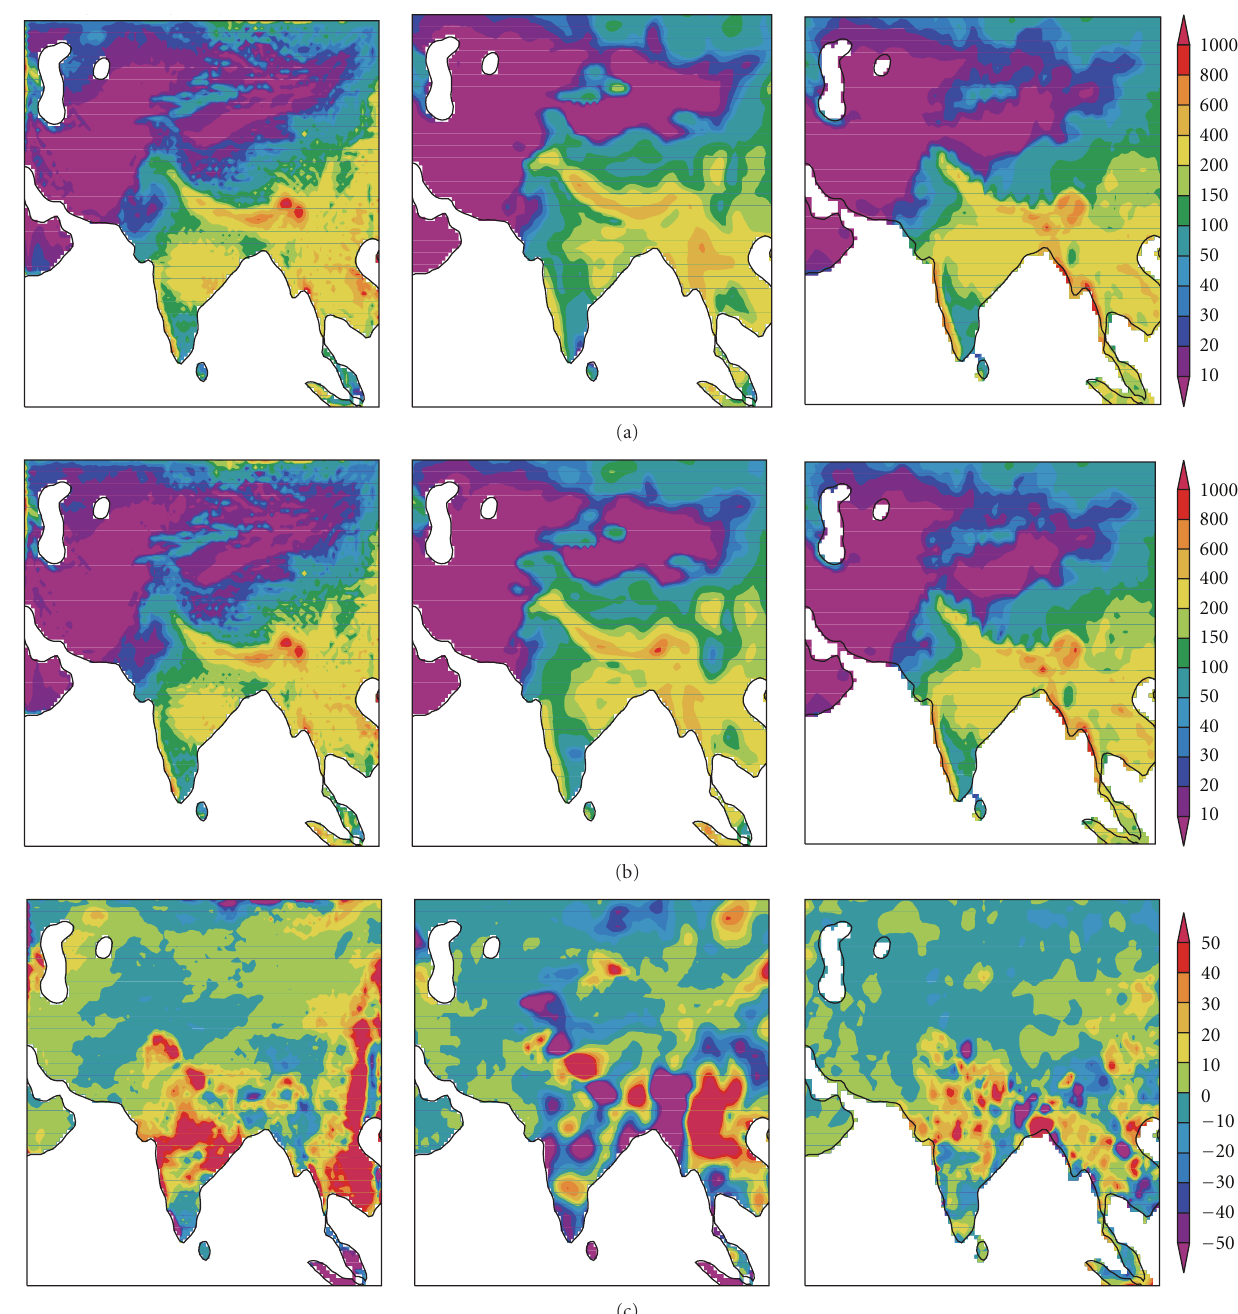
Figure 12: Precipitation (mm; shaded) for HIRHAM (left), ERA40 (middle) and GPCC4 (right); summer monsoon (JJAS) 1970–1980 (a), 1990–2000 (b) and the di ff erence “1970–1980 minus 1990–2000” (c).